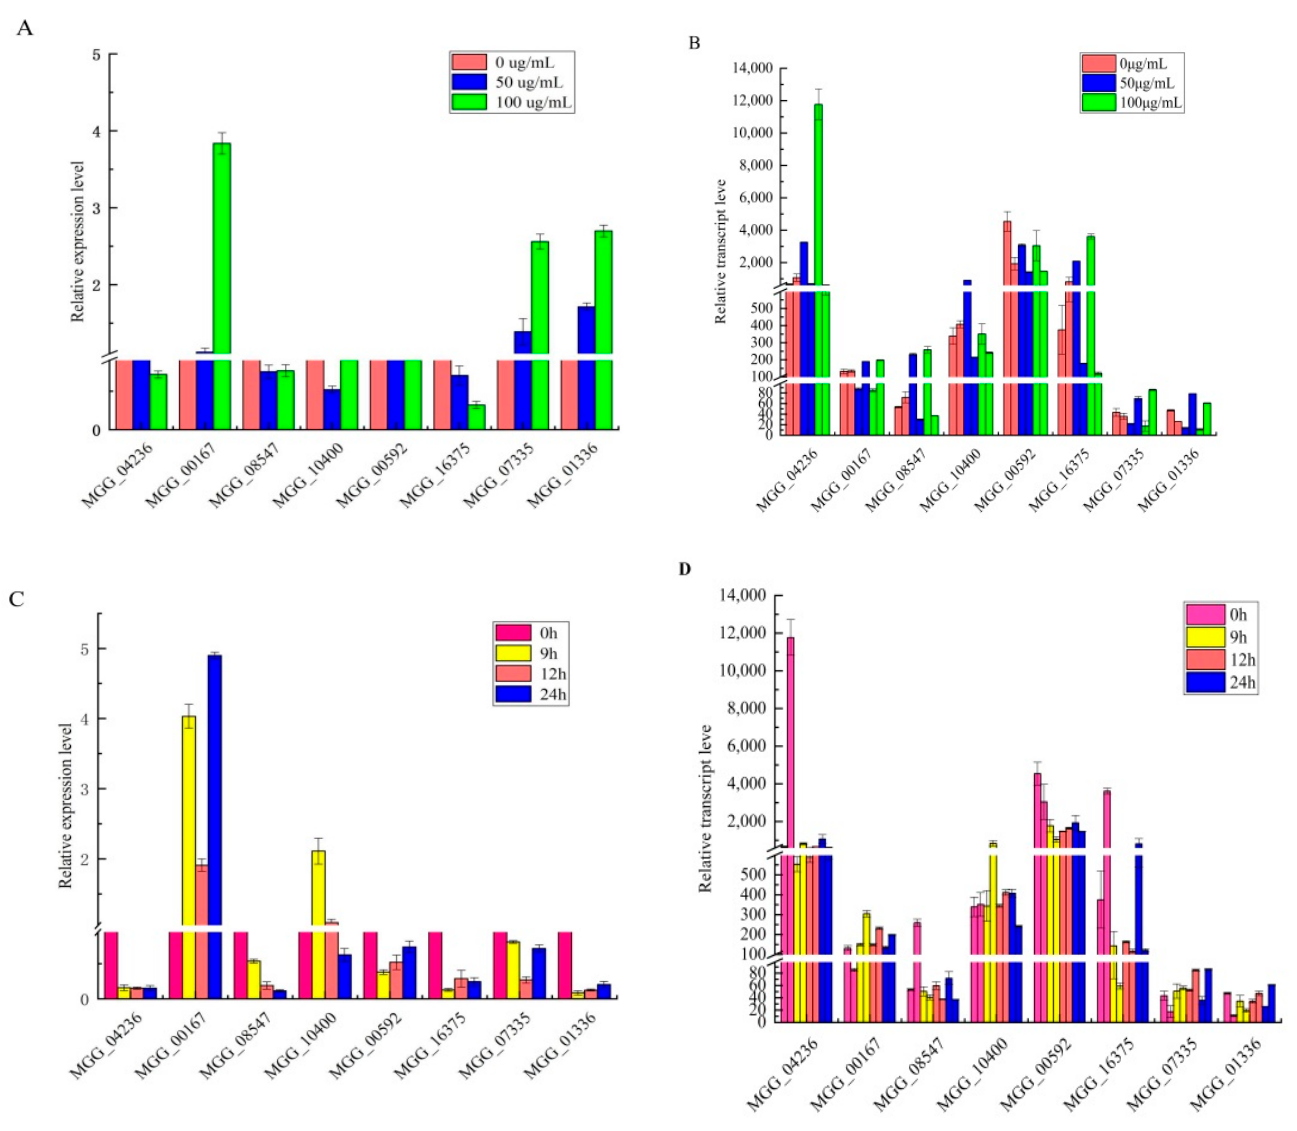
Figure 5. RT-qPCR verification of key genes of resistance to citral in M. oryzae . ( A , B ) The expression trend of genes as characterized by qPCR was consistent with that of RNA-seq analysis after 9, 12, and 24 h of treatment with citral (100 µ g/mL). ( C , D ) The expression trend of genes as characterized by qPCR was consistent with that of the RNA-seq analysis after treatment with 0, 50, and 100 μ g/mL of citral for 24 h. All values are based on three technical repeats and presented as means ± SD. Different characters indicate a statistically significant difference at p < 0.05 by t -test.